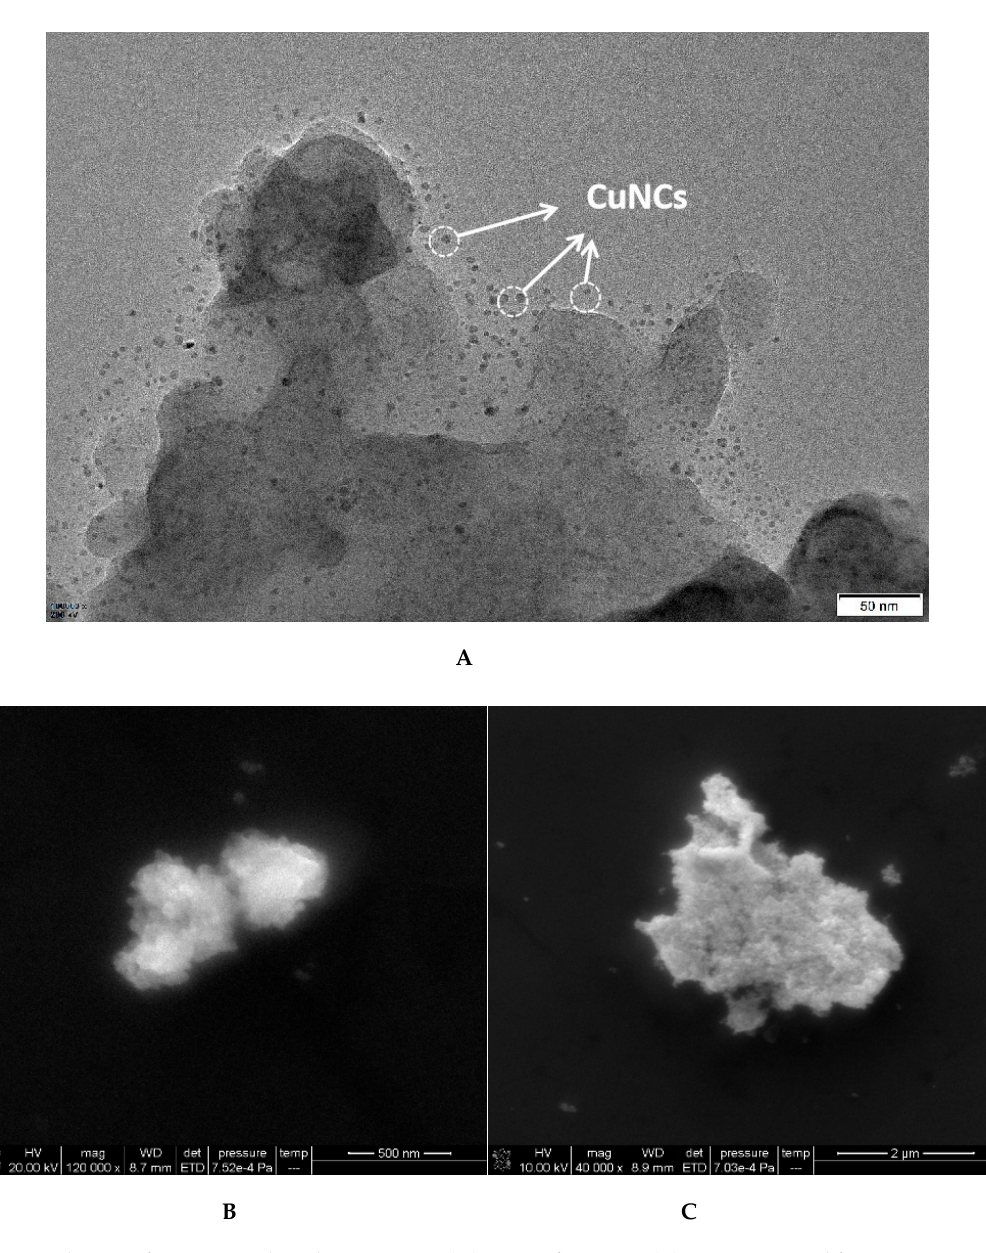
Figure 2. TEM and SEM of CuNCs and analysis system. ( A ) TEM of CuNCs; ( B ) SEM, 1.2 nmol/L CuNCs + 27.5 nmol/L Apt + 2.52 μ mol/L HAuCl 4 + 1.87 mol/L ethanol + 0.65 mol/L HCl + 112.5 ng/L OTC; ( C ) SEM, 1.2 nmol/L CuNCs + 27.5 nmol/L Apt + 2.52 μ mol/L HAuCl 4 + 1.87 mol/L ethanol + 0.65 mol/L HCl + 225 ng/L OTC.